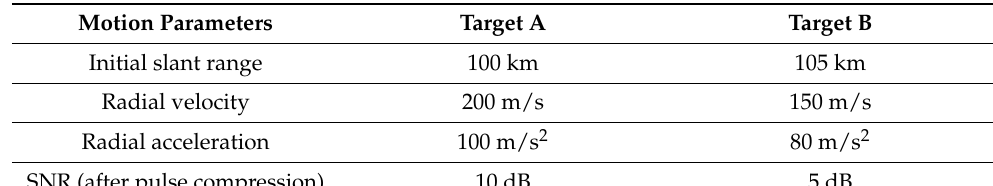
Table 4. Motion parameters of targets.